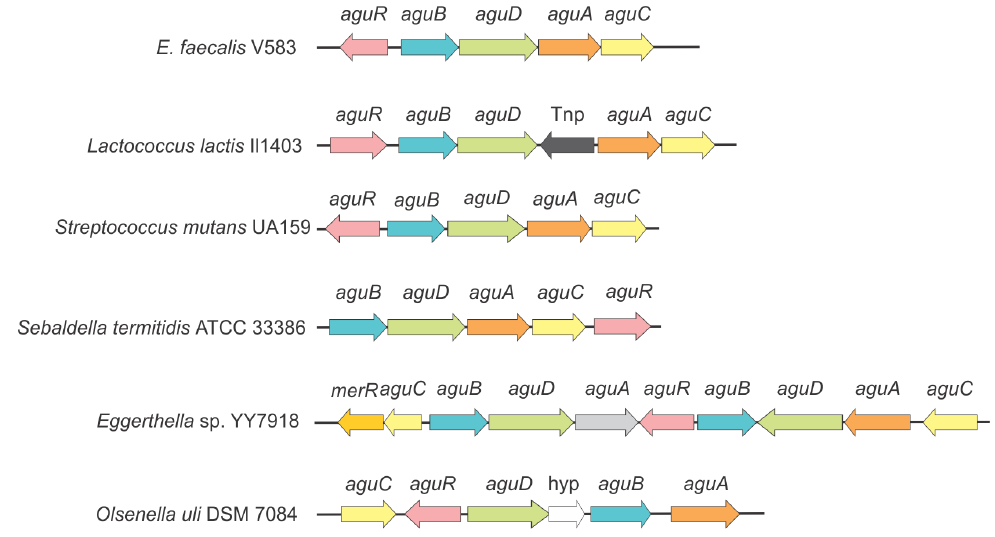
Figure 6. Gene context analysis of the AgDI system from different sources.